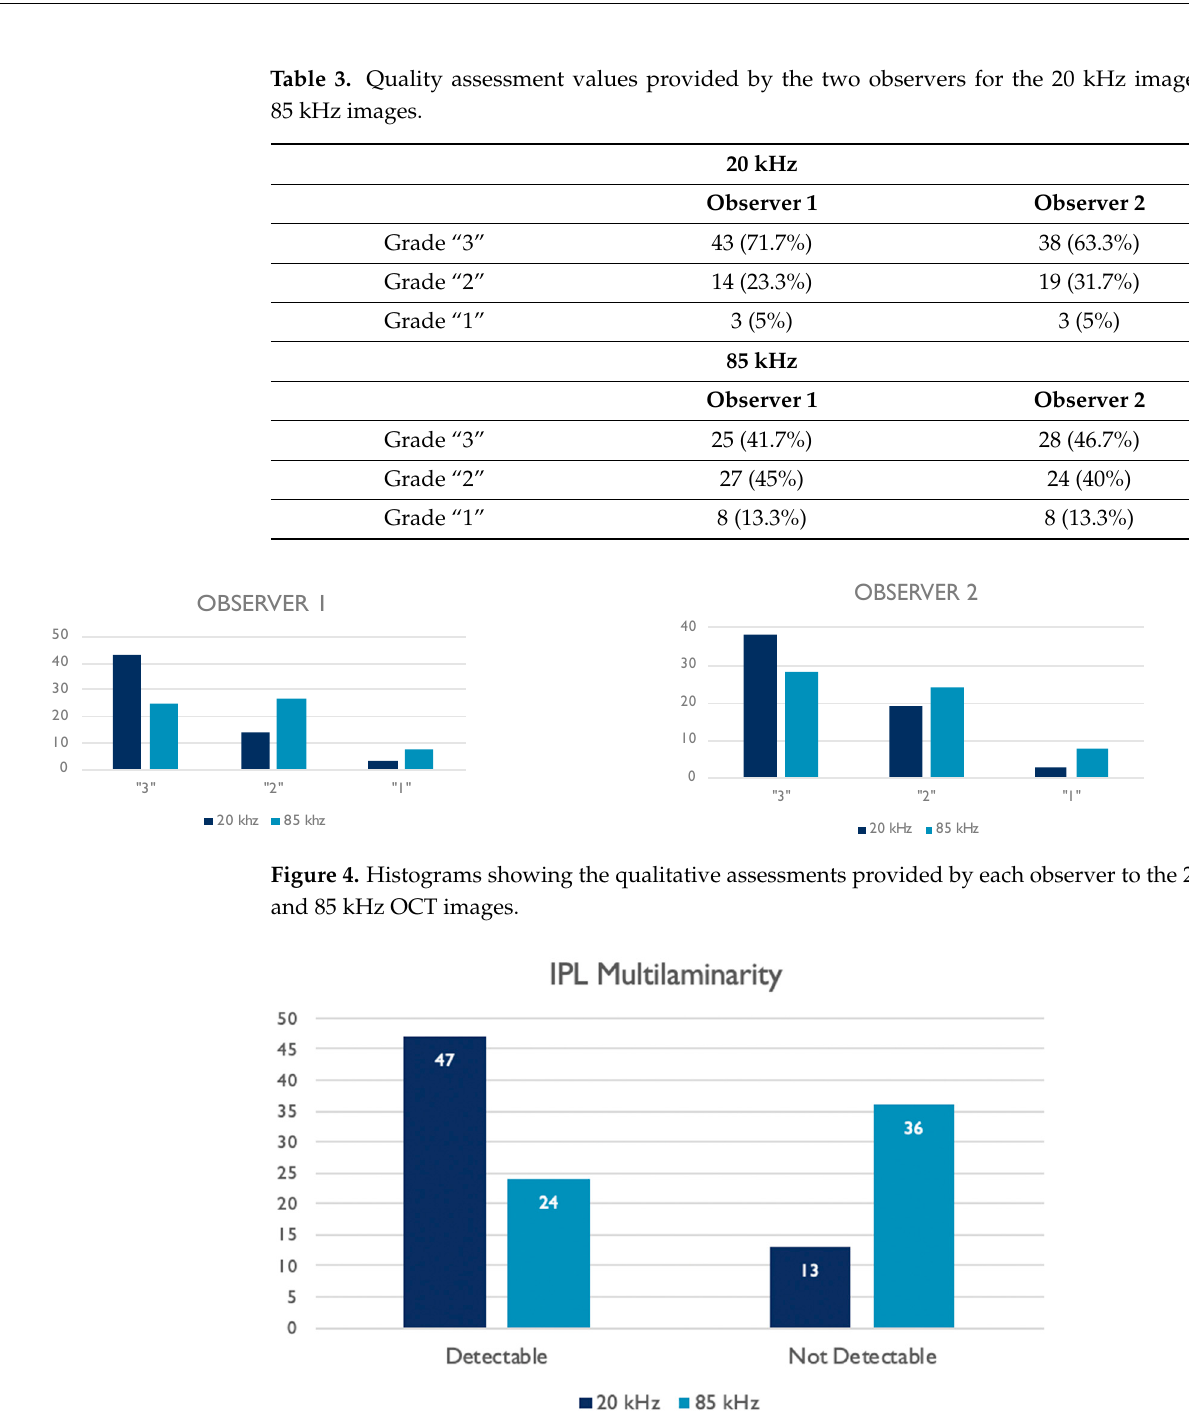
Figure 5. Histograms showing the number of images where the IPL multilaminarity was detectable.